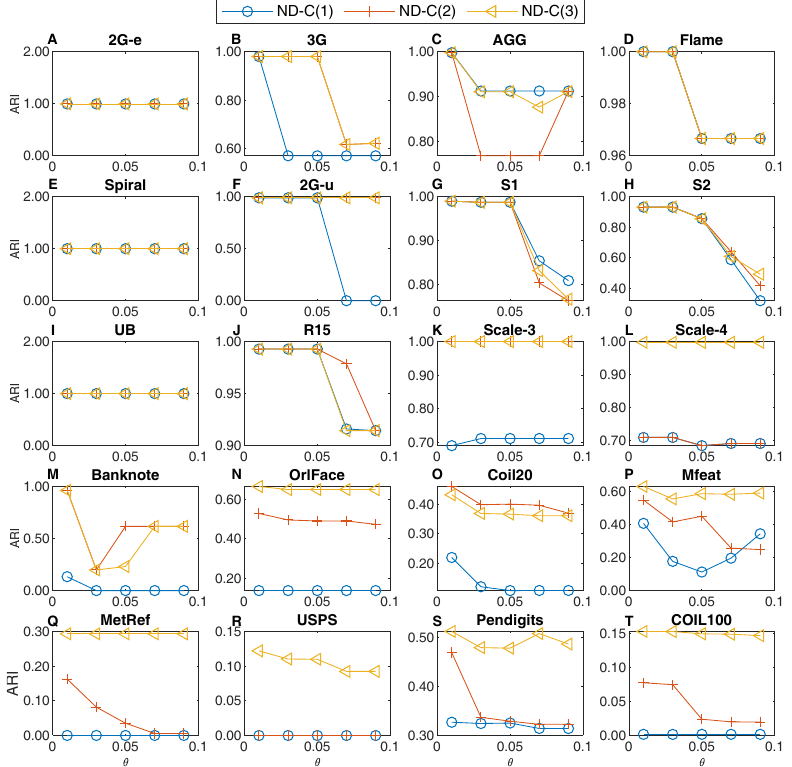
Figure 14. Comparison of the sensitivity of ND-C(1), ND-C(2), and ND-C(3) to parameter θ